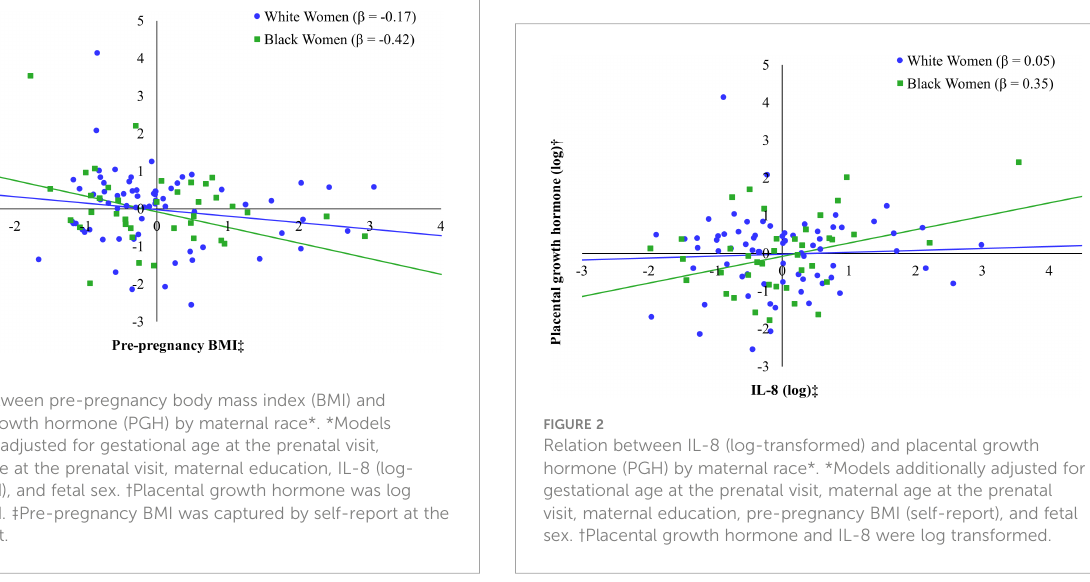
White race: b = -0.68, p < 0.01; education: b = -0.29, p < 0.01). This model explained 11% of the adjusted variance in BWz ( F (6, 91) = 3.04, p = 0.009). When strati fi ed to the Black participants only, IL-8 was negatively associated with BWz, although this trend approached but did not attain statistical signi fi cance ( b = -0.40, p = 0.06) (see Figure 3). In fact, none of the predictors signi fi cantly predicted infant BWz when considered individually ( F (5, 26) = 1.06, p = 0.41). When stratifying to White participants only, maternal educational attainment was negatively associated with infant BWz ( b = -0.26, p = 0.02) and BMI was positively associated with infant BWz (see Figure 4), although this trend did not attain the cutoff for statistical signi fi cance ( b = 0.21, p = 0.06). This model explained 11% of the adjusted variance in infant BWz, which was statistically signi fi cant ( F (5, 60) = 2.55, p = 0.04).